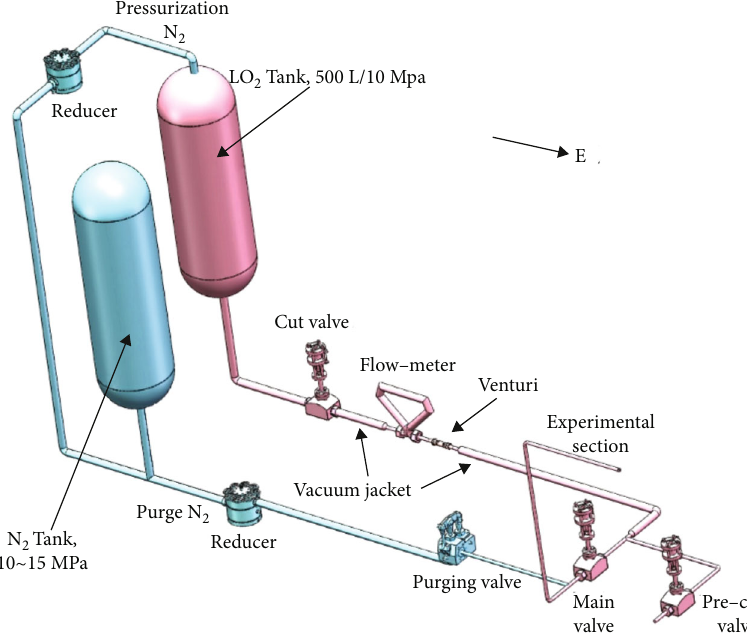
Figure 4: Experimental system of the present